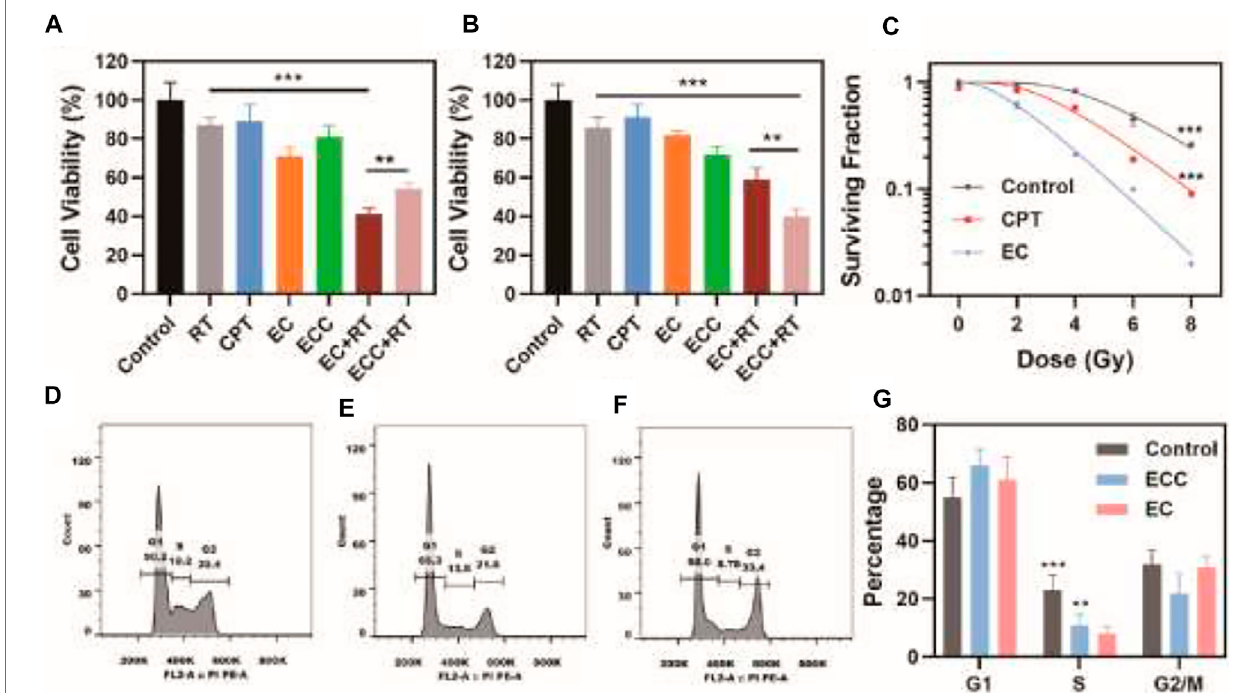
FIGURE 2 | Assessment of in vitro therapeutic ef fi cacy. (A) Patient-derived cell and (B) HeLa cell viability following the indicated treatments. (C) Colony formation assay. (D – G) Flow cytometry was used to assess cell cycle progression in patient-derived cells treated with (D) PBS, (E) ECC, and (F) EC, with a (G) corresponding quantitative cell cycle analysis. * p < 0.05, ** p < 0.01, *** p < 0.005; Student ’ s t-test.